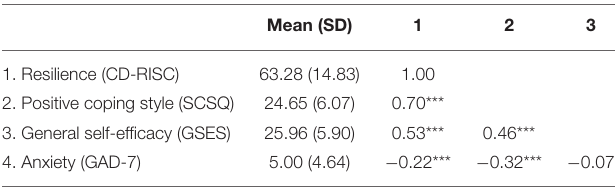
TABLE 2 | Pearson’s correlation among resilience, self-efficacy, coping style and anxiety ( N = 390). Mean (SD)